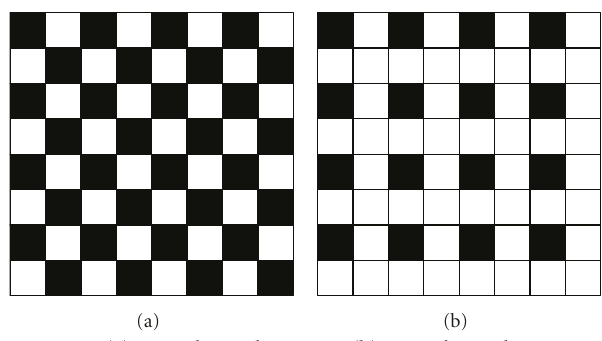
Figure 8: (a) 2 :1 subsample pattern. (b) 4 :1 subsample